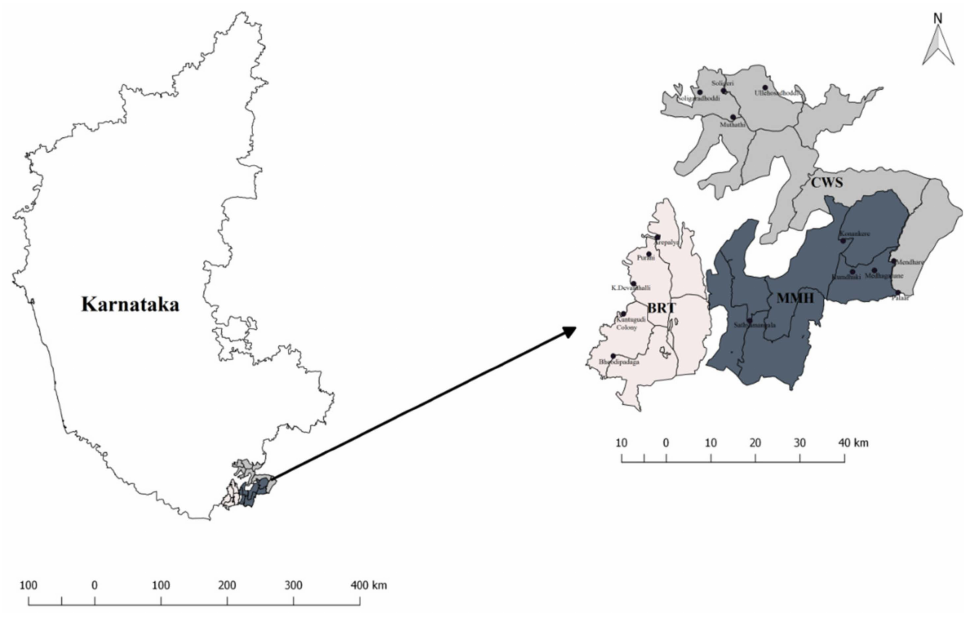
Figure 1. Study sites and sample